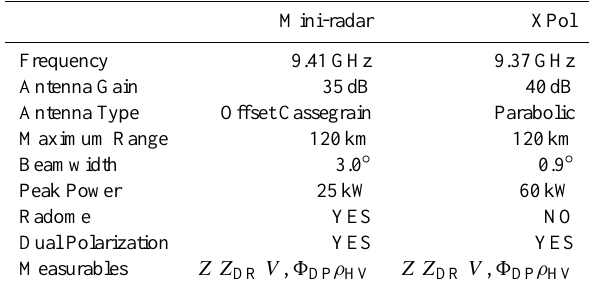
Table 1. HYDRORAD mini-radar and XPol operational character- istics.